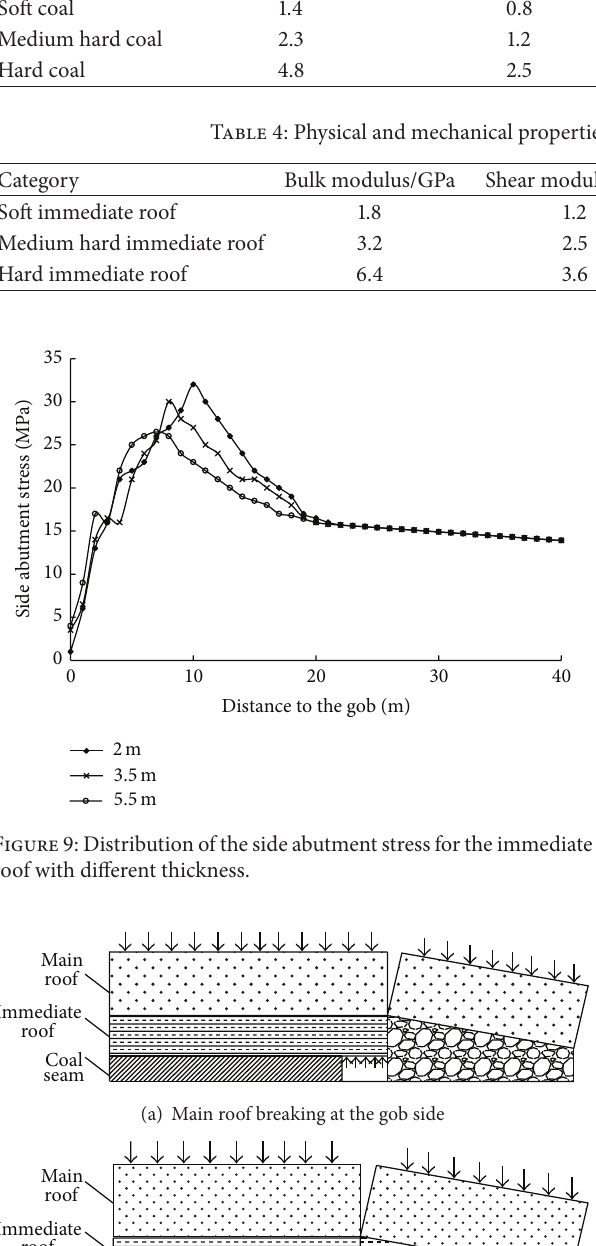
1.63, and 1.82, respectively, signifying an increasing trend; compared to the soft immediate roof, the concentration coefficient for the medium hard immediate roof and hard immediate roof increases to 7.9% and 20.5%,